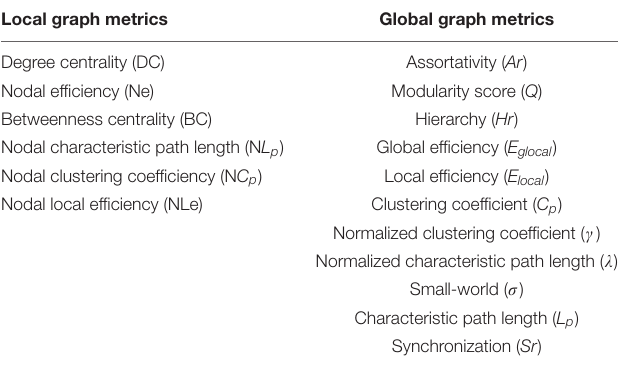
TABLE 1 | Local and global graph metrics of the morphological brain